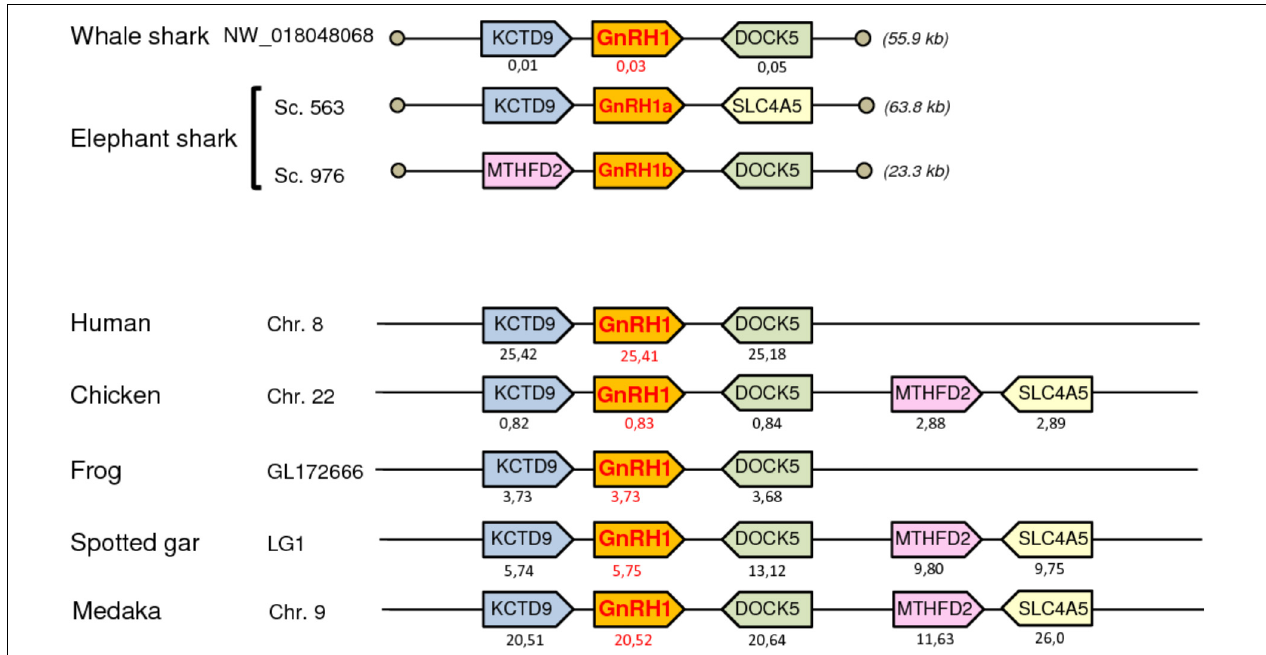
FIGURE 4 | Synteny of genes in the GnRH1 locus in catshark, whale shark, and elephant shark plus five selected bony vertebrate species (human, chicken, western clawed frog, spotted gar, and medaka). Genes are represented by block arrows. Genes with conserved synteny are colored. Position of the genes (in megabases, Mb) is displayed below each box, according to the Ensembl database. Empty circles indicate the end of scaffolds. The detailed chromosomal locations of genes displayed in this map are included in Supplementary Table S3